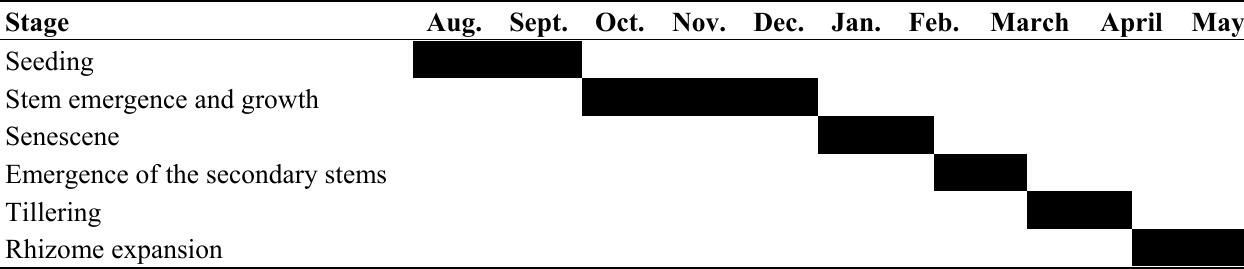
Table 1. The growth and development stages of